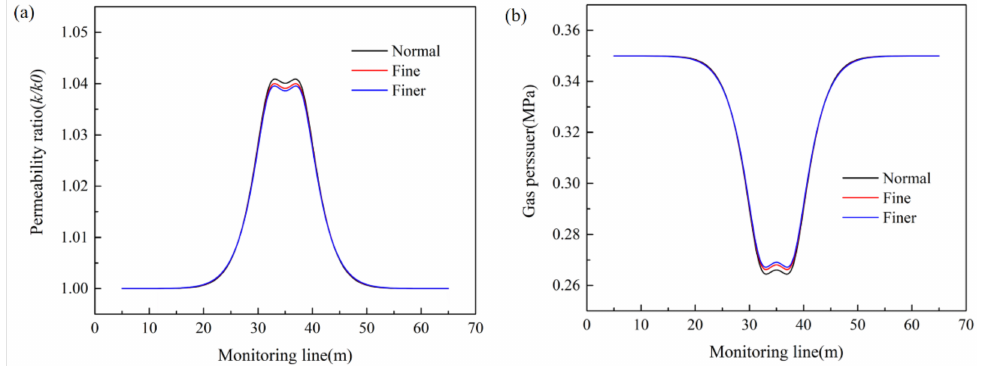
Figure 19. Permeability and gas pressure distribution curves of different mesh types at 10 d of drainage: ( a ) Permeability distribution curve. ( b ) Gas pressure distribution